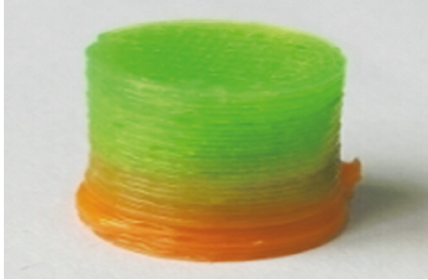
Figure 16: 3D printing object at the temperature of 230 ∘